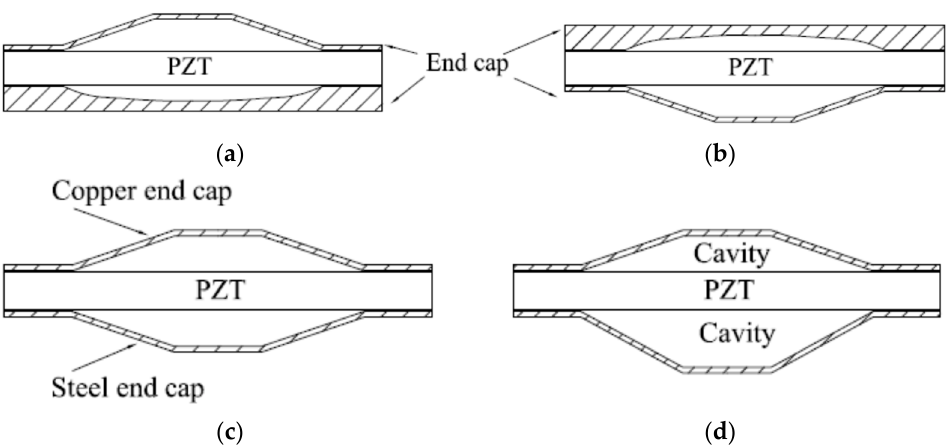
( b ) Figure 22. Structure diagrams of dual drive cymbal. ( a ) Two piezoelectric discs ( b ) Two piezoelec- tric rings. In order to broaden the resonance band of intelligent structures, the United States